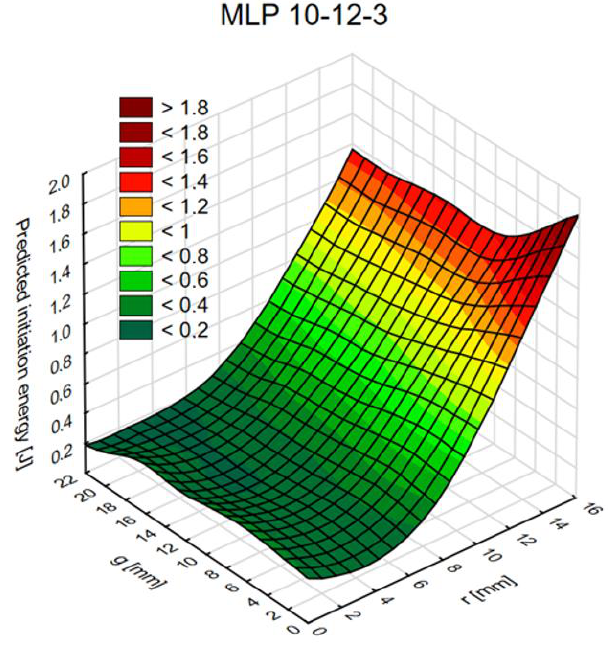
Figure 15. The graph of initiation energy values as a function of radius (r) and thickness (g).